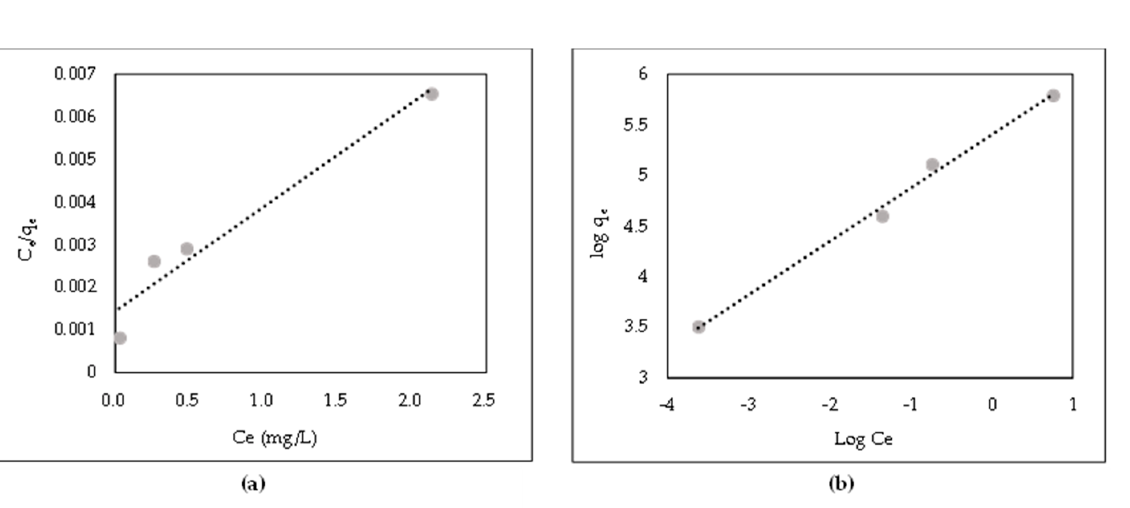
Figure 10. Linear isotherm plot of AR88 removal onto ZL–CH hydrogel (pH 2.0). ( a ) Langmuir isotherm model; ( b ) Freundlich isotherm model.